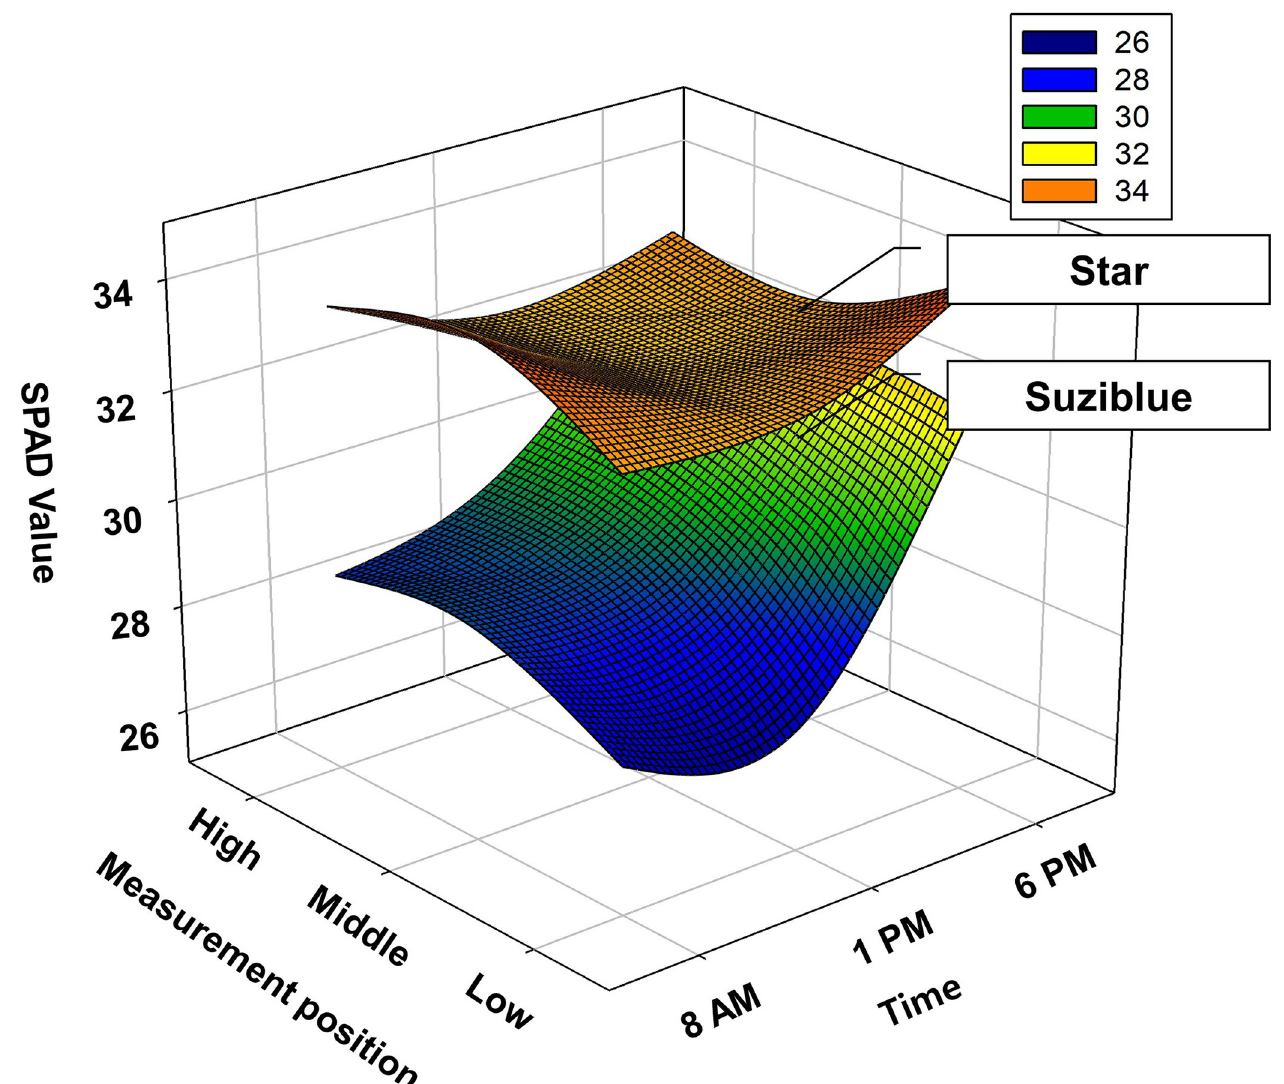
Fig 1. SPAD values of Star and Suziblue at different time and